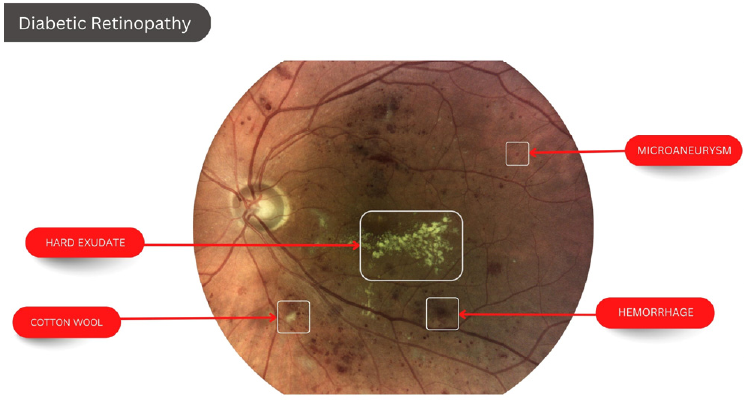
Figure 1. Diabetic Figure 1. Diabetic Retinopathy.